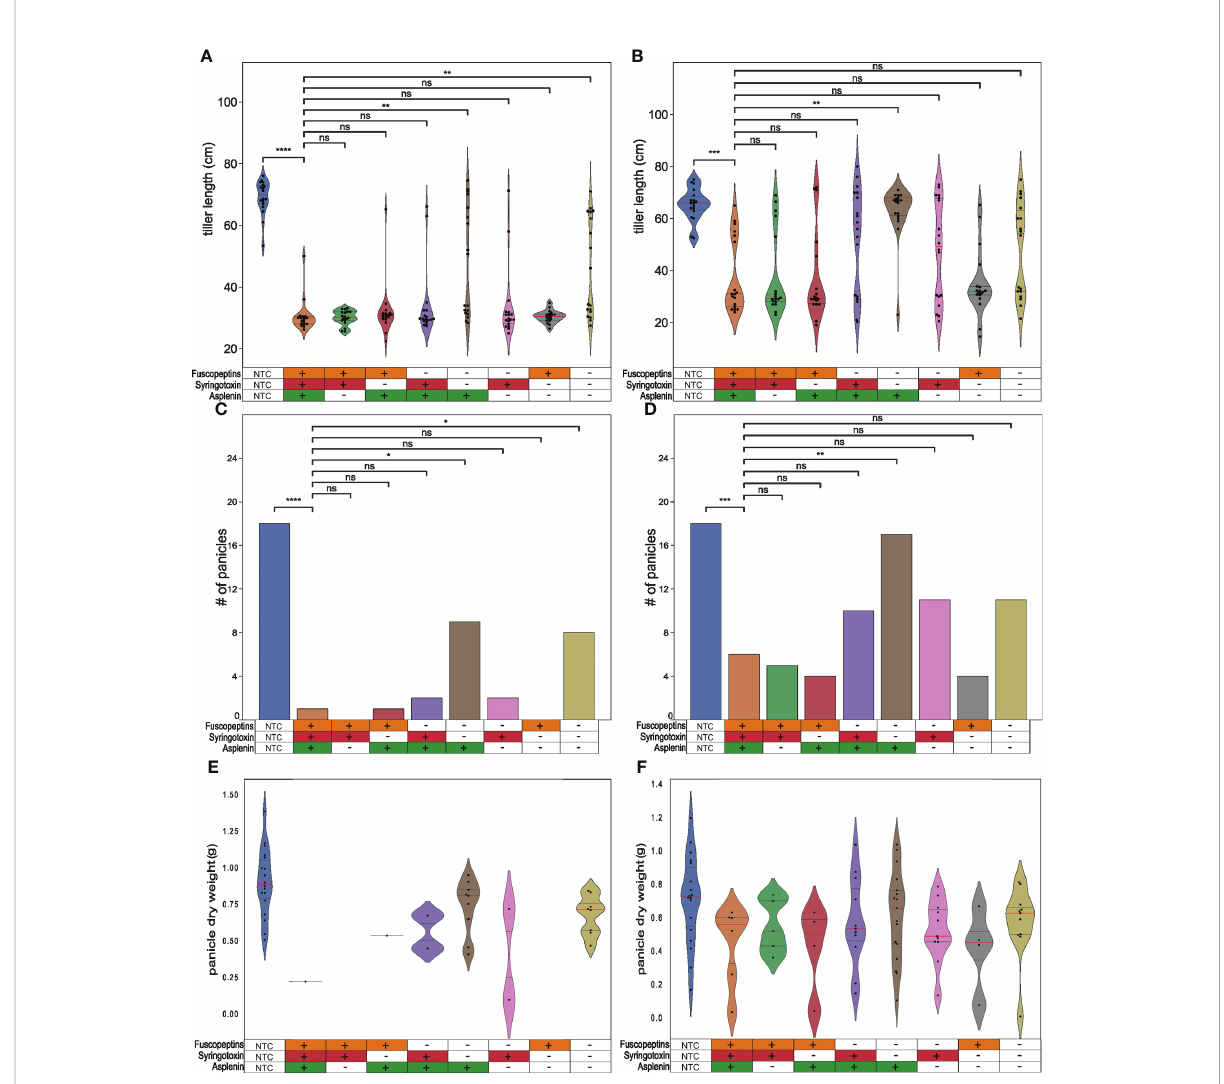
FIGURE 5 Effect of P. fuscovaginae UPB0736 and CLP mutants on tiller length and panicle formation. Rice plants were infected by injecting a bacterial suspension of P. fuscovaginae UPB0736 WT or mutants for the indicated CLPs. The non-treated controls (NTCs) were injected with saline solution. Parameters were scored after complete grain fi lling. (A, B) Violin plot showing the tiller length. The dots indicate the single measurements. The red and the two gray lines are respectively the median and the two quartiles. (C, D) Number of emitted panicles. (E, F) Violin plot showing the panicles dry weight. The dots indicate the single measurements. The red and the two gray lines are respectively the median and the two quartiles. Plants were infected about (A, C, E) one week and (B, D, F) two weeks before the start of booting stage. Tables below the fi gures refer to the phenotypes of WT and CLP mutants, as indicated in Table 3. (A, B, E, F) Statistical signi fi cance was calculate with Kruskal- Wallis and post hoc pairwise Dunn tests with Holm-Sidak correction. (C, D) Statistics was calculated with post-hoc chi-square tests